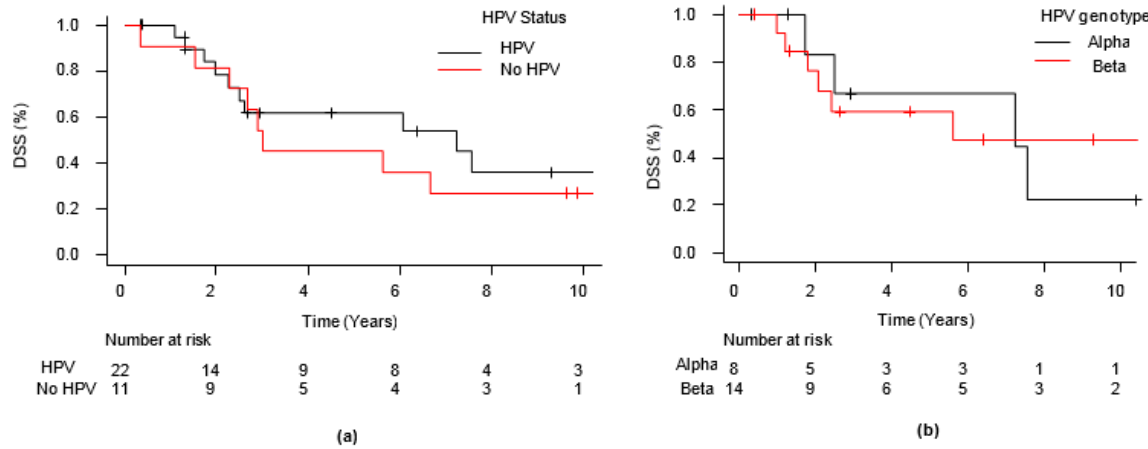
Figure 2. Five-year disease-specific survival. ( a ) Five-year disease-specific survival (DSS) rate in relation to Human Figure 2. Five ‐ year disease ‐ specific survival. ( a ) Five ‐ year disease ‐ specific survival (DSS) rate in Papilloma Virus (HPV) presence; ( b ) five-year DSS rate in relation to HPV genotype.